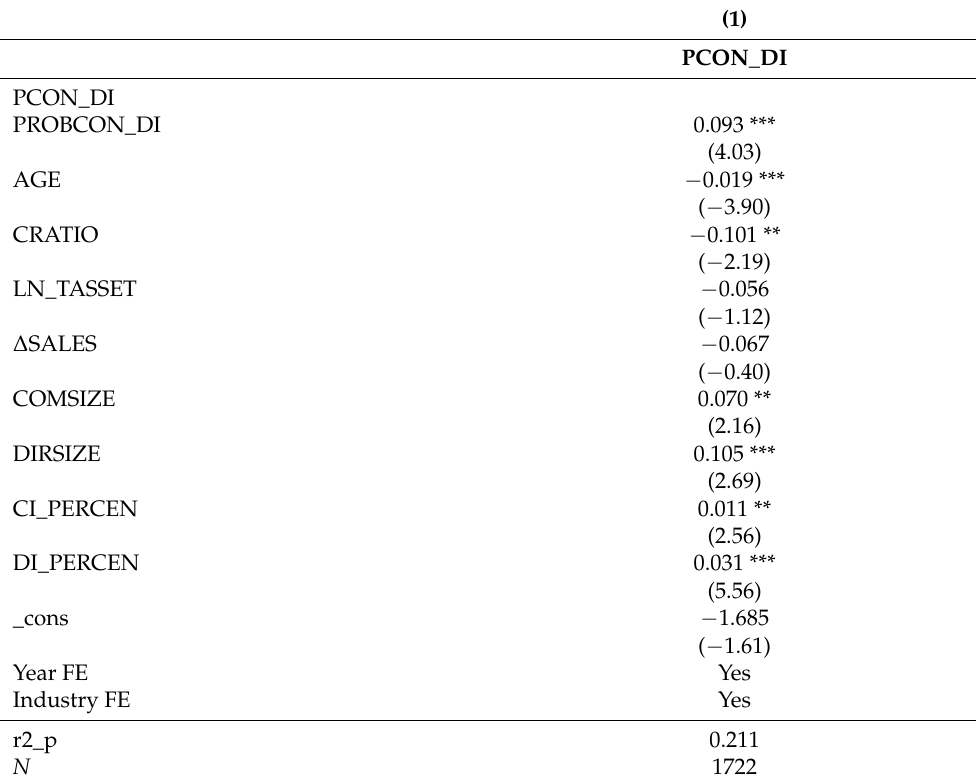
Table 10. Results of The Fist-Stage Regression Model: Determinants of Firm Political Connections From